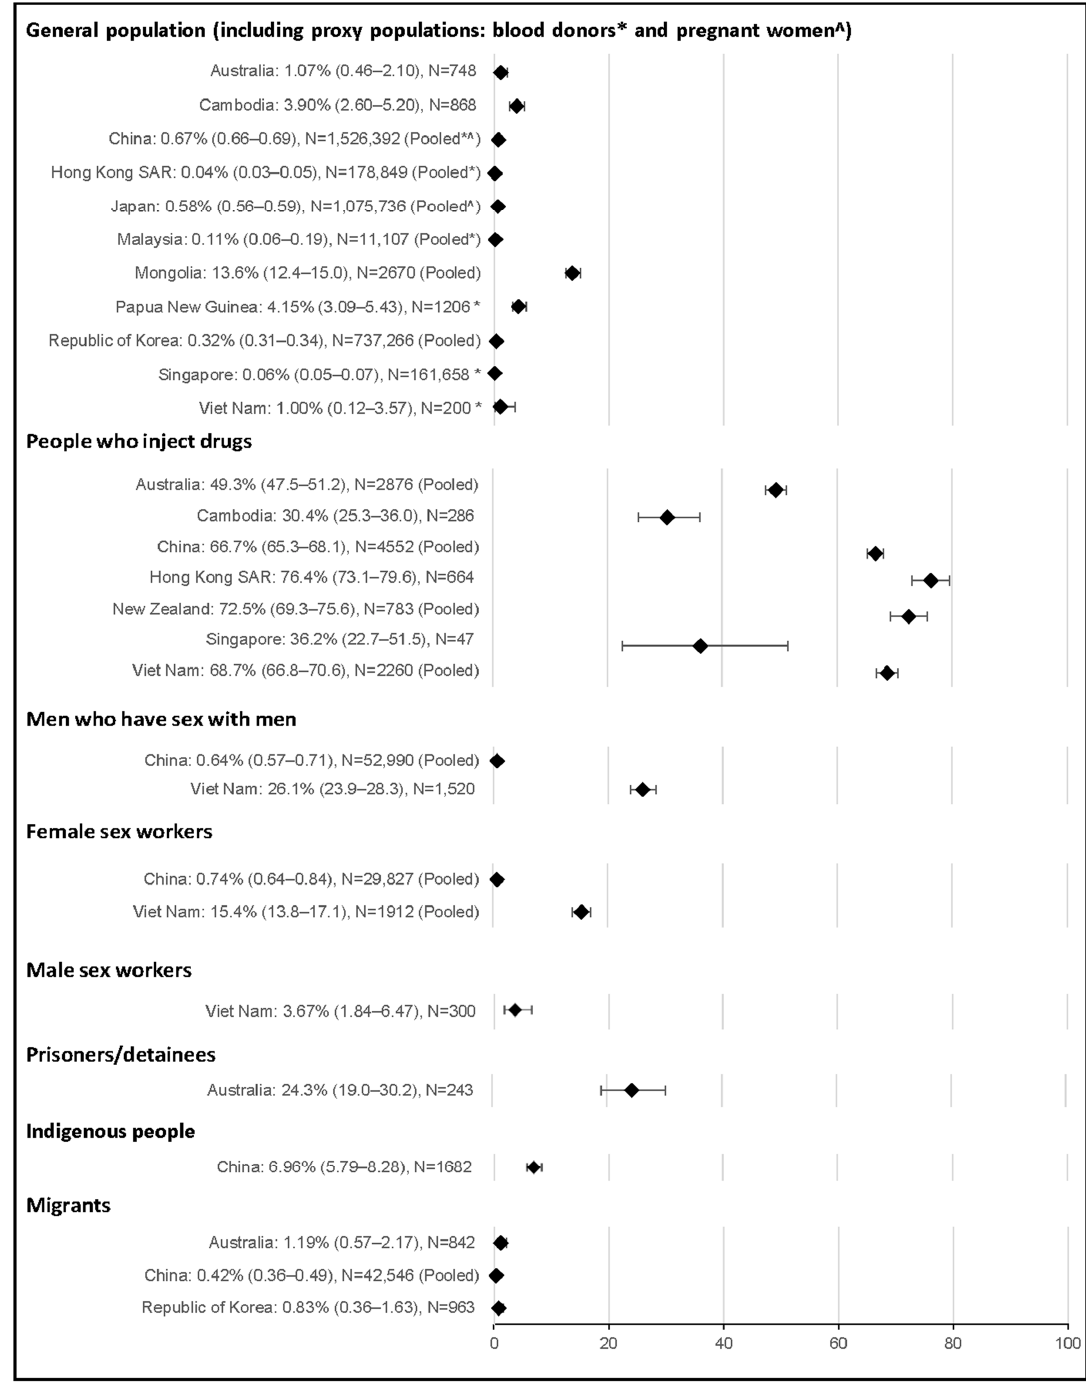
Figure 2. Forest plots HCV antibody prevalence by key population and country.